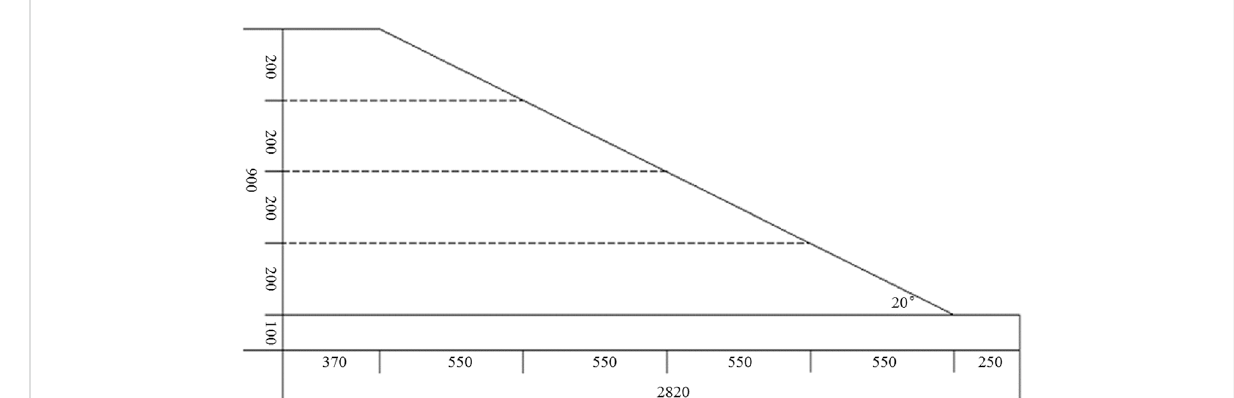
FIGURE 3 Loess-slope model (unit: mm).